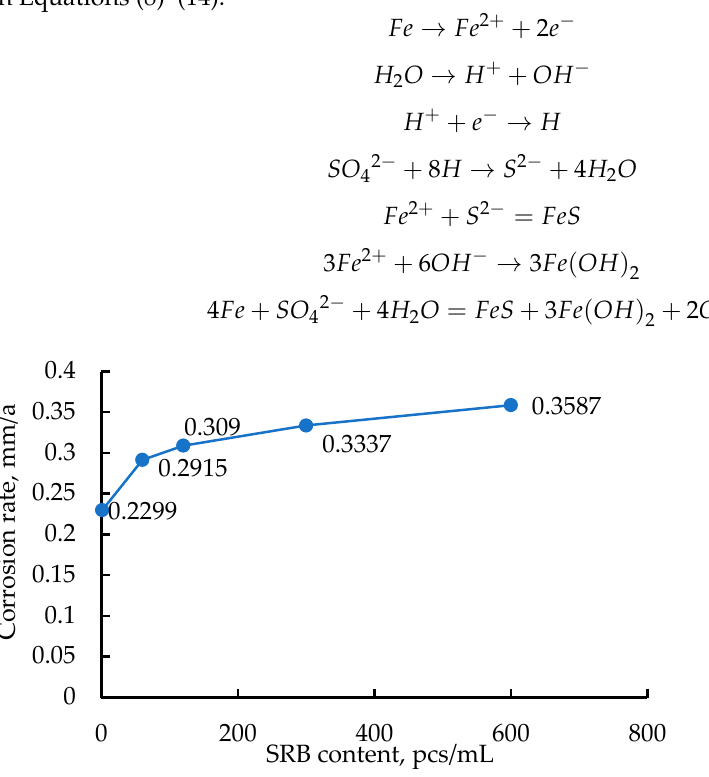
Figure 5. Variation curve of dynamic corrosion rate of 20# steel with SRB content.